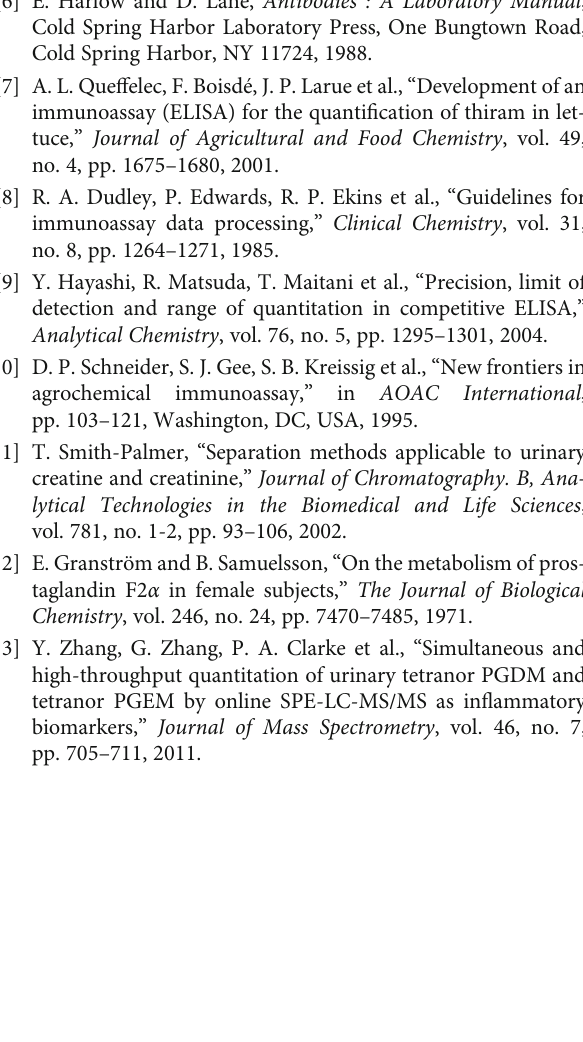
Supplementary Table 1: the composition of arti fi cial urine. Supplementary Table 2: recovery from SPE. Supplementary Table 3: cross-reactivity among tetranor-PGDM and related lipids. (Supplementary